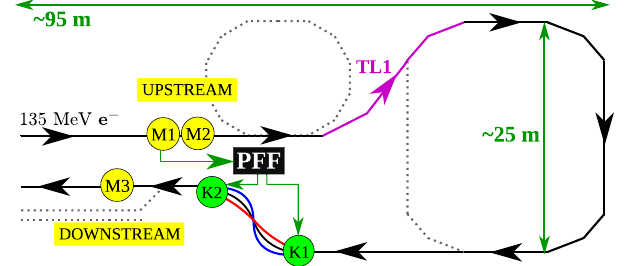
FIG. 2. Schematic of the CTF3 PFF prototype, showing the phase monitors ( M 1 , M 2 and M 3 ) and kickers ( K 1 and K 2 ). The black box PFF represents the calculation and output of the correction. Bunches arriving early at M 1 are deflected on to longer trajectories in the chicane (blue), and bunches arriving late on to shorter trajectories (red). Dashed lines indicate beam lines that are not used.